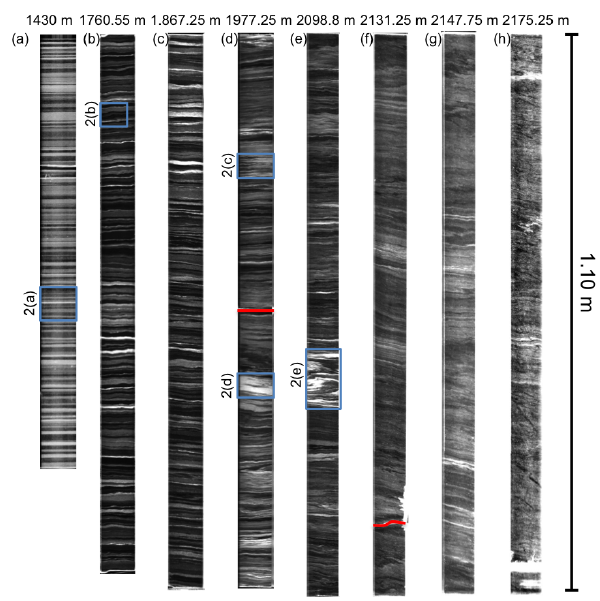
Figure 1. Visual stratigraphy overview. Line scan images of differ- ent depths. A Gaussian filter was applied to images shown in (a) , (d) , (e) , (f) , (g) , and (h) to enhance the visibility of the layers. Red lines indicate fractures. Blue squares and associated figure codes in- dicate location of enlargements shown in Fig. 2. The 1.10m line on the right indicates the scaling of the images and is also the typical length of a recovered core